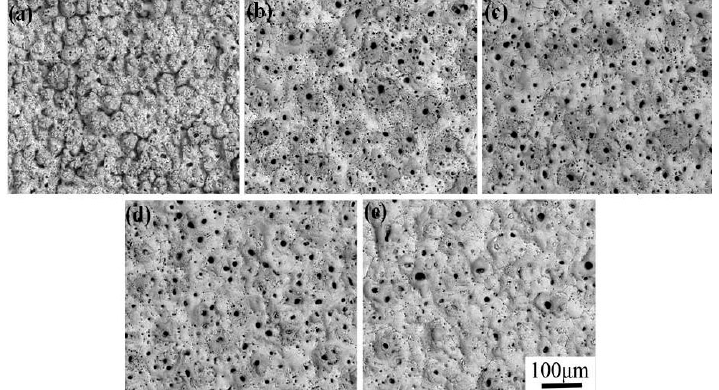
Figure 1. SEM images of MAO coatings at different KMnO 4 concentration:( a ) 0 g/L; ( b ) 0.8 g/L; ( c ) 1.6 g/L; ( d ) 2.4 g/L; ( e ) 3.2 g/L.